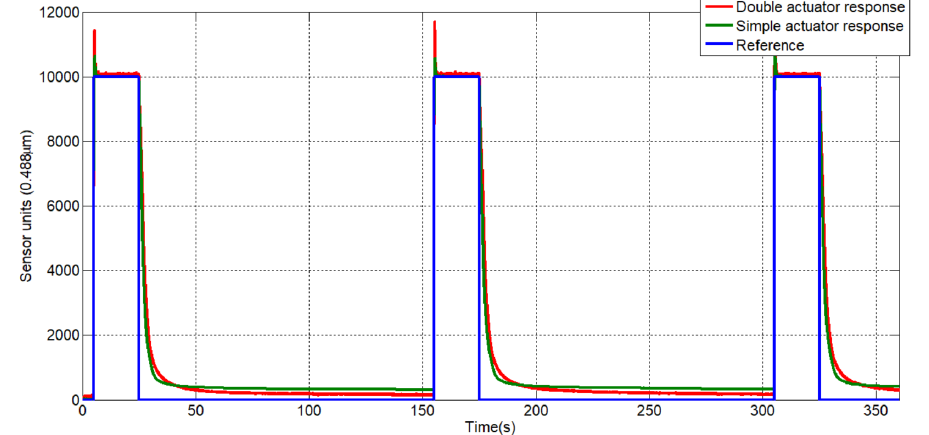
Figure 13. SMA double vs. simple actuators